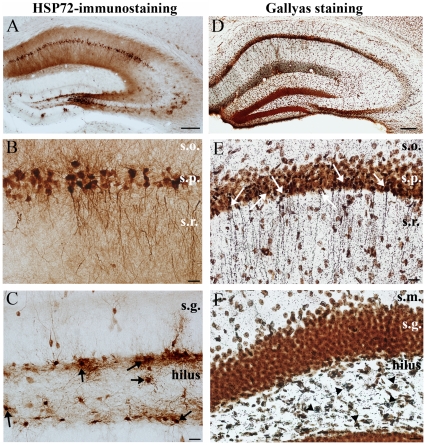
Cell loss and degeneration at day 3 post pilocarpine.HSP72 is heavily expressed in a large population of pyramidal cells (A, B) and in some mossy cells, indicating that they were exposed to excitotoxic insult. In contrast, hardly any granule cells are stained (arrows) (C) compared to 1 day post SE. Gallyas silver impregnation reveals that in the early latent period principal cell loss begins at a large scale (orange cells are alive). Dark silver deposit is present in neurons irreversibly damaged (D, E, F). Argyrophilic cell degeneration can be seen in the vulnerable regions of the hippocampus, like the CA1 pyramidal cell layer (E) and the hilar region (F) (arrows in the CA1, arrowheads in the hilus). (s.o.: str. oriens, s.p. str. pyramidale, s.r.: str. radiatum, s.m.: str. moleculare, s.g.: str. granulosum) Scale: A, D 200 µm, B, E, F, C and F: 50 µm.